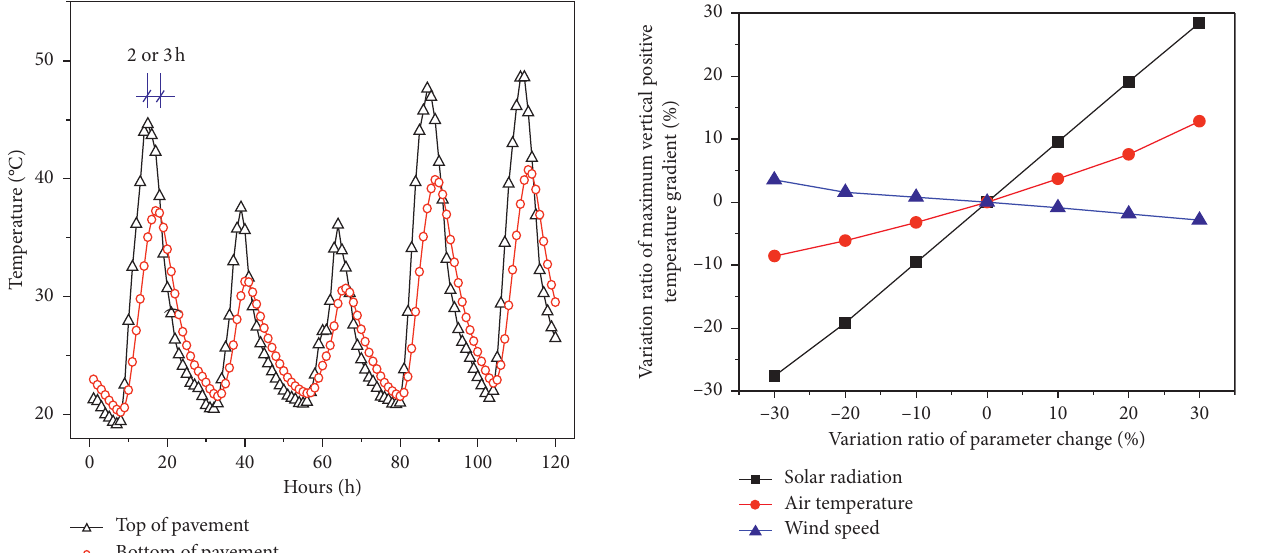
Figure 10: Sensitivity curves of the